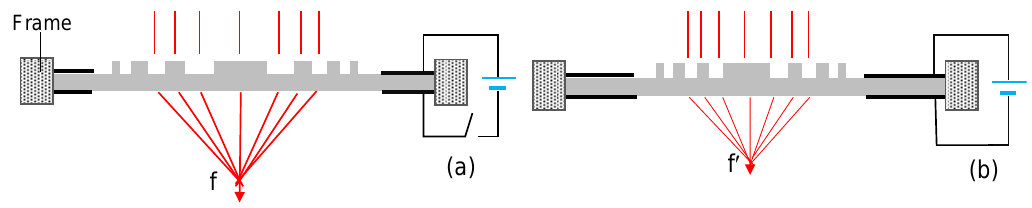
Figure 6. Device structure of an FZP lens using a DEA film: ( a ) no voltage and ( b ) with a voltage .